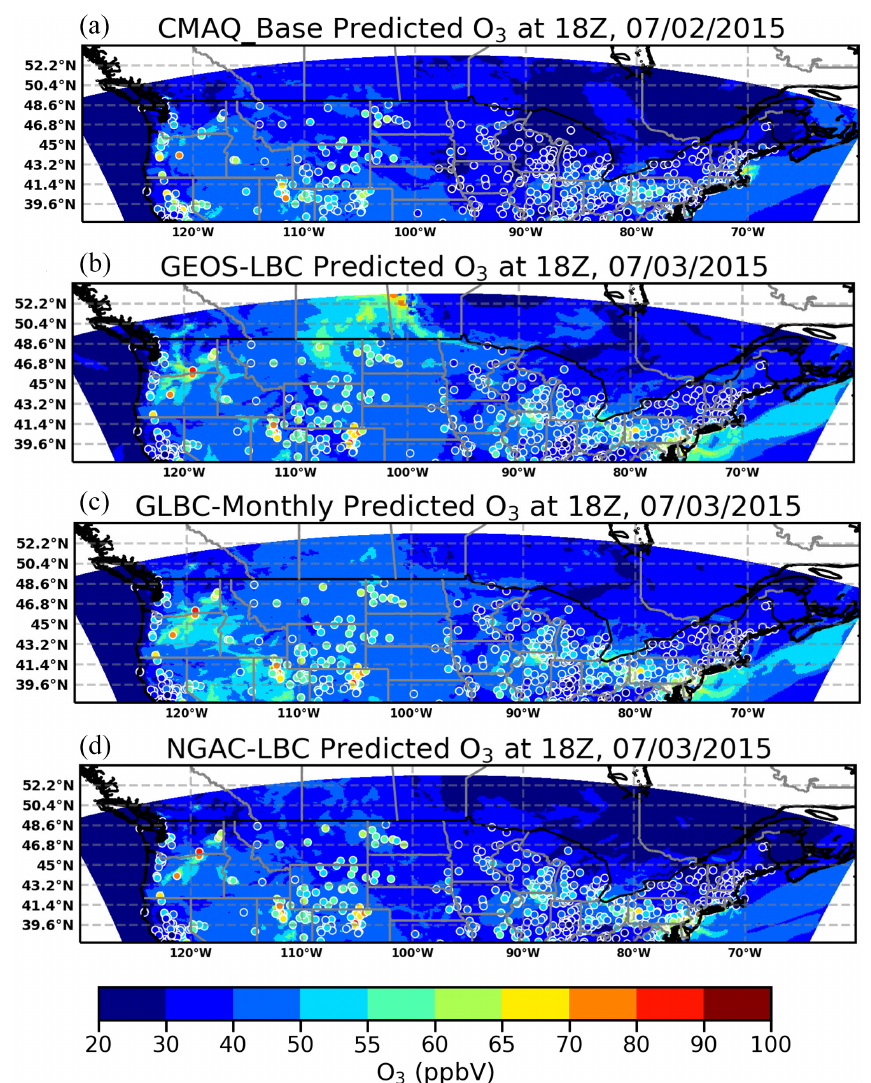
Figure 9. Same as Fig. 8 but for O 3 . Please note that the dates in this figure are given in the format of month day year (mm/dd/yyyy). This figure is plotted using cartopy https://scitools.org.uk/cartopy/docs/latest/ (last access: February 2021), which uses the national and state border information from http://www.naturalearthdata.com/ (last access: February 2021). Please note that the above figure contains incomplete US state